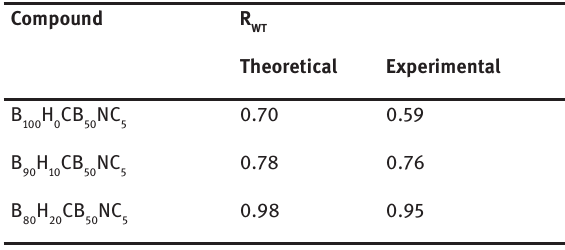
obtained from model and experimental data.